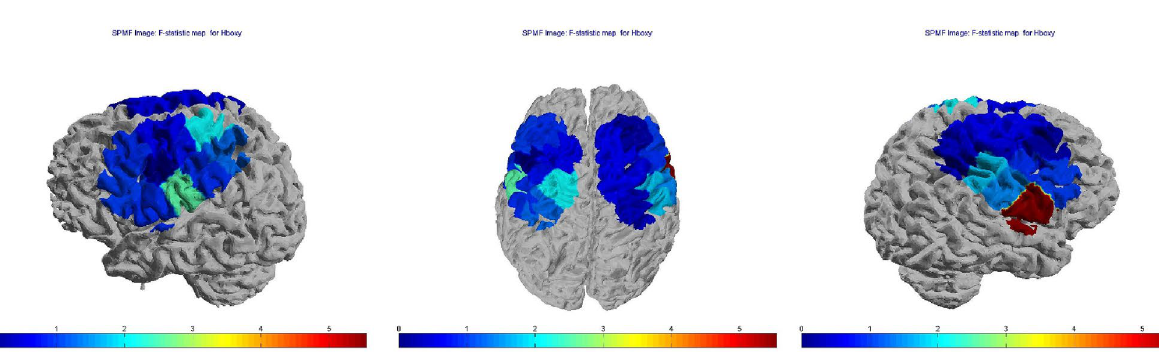
Figure 5. Topographic maps of F-statistic in the comparison among conditions (Resting State vs Grasping Flat vs Grasping Sharp-tip object), session (Time-to-contact detection vs Observation-only) and groups (FM patients vs controls). Blue areas represent channels with no significant change in hemoglobin levels, red areas represent channels where the variations in hemoglobin levels were